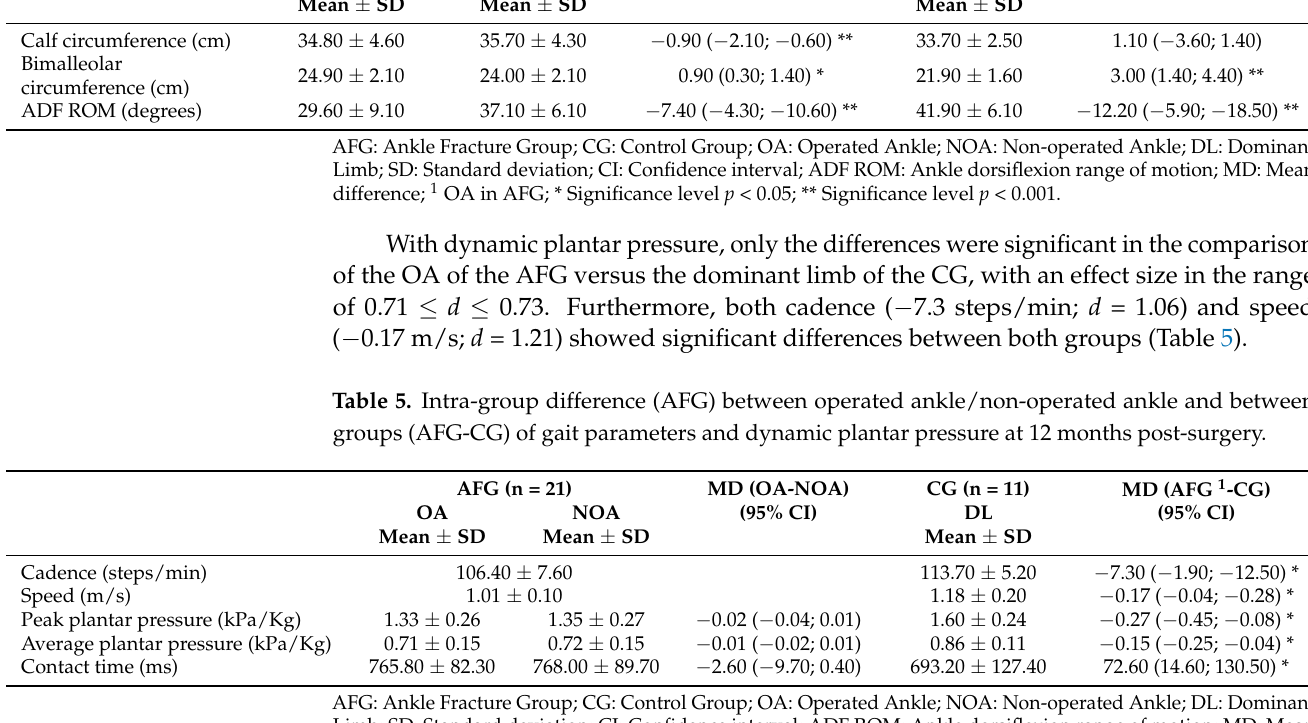
AFG: Ankle Fracture Group; CG: Control Group; OA: Operated Ankle; NOA: Non-operated Ankle; DL: Dominant Limb; SD: Standard deviation; CI: Confidence interval; ADF ROM: Ankle dorsiflexion range of motion; MD: Mean difference; 1 OA in AFG; * Significance level p <